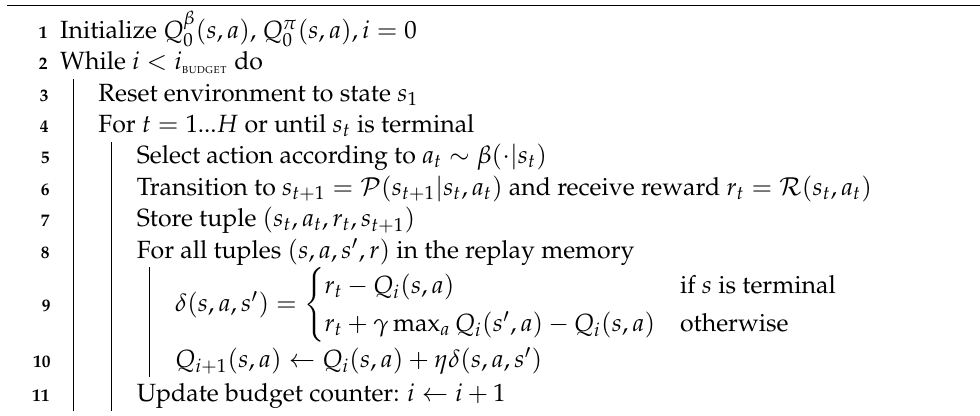
Algorithm A1: Tabular Q-Learning with Replay